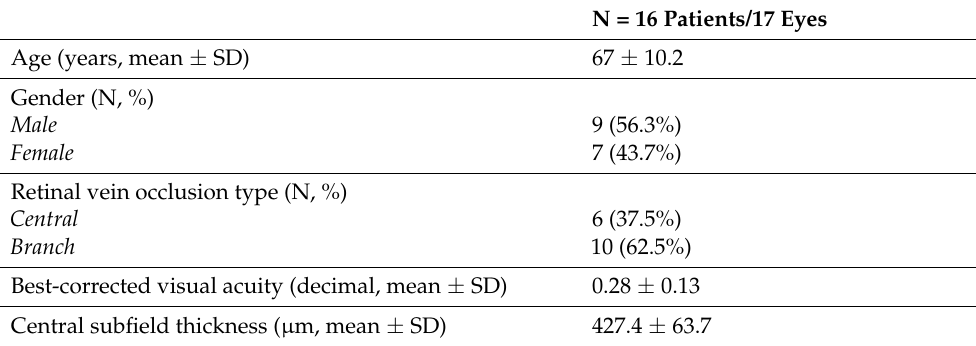
Table 1. Demographic and clinical characteristics of the study sample at baseline.